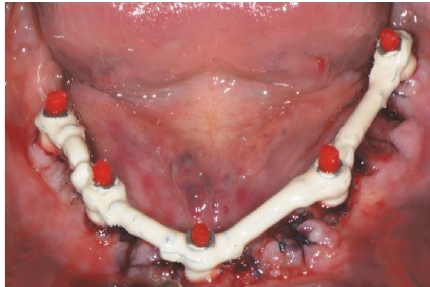
Figure 8: After the intraoral welding, the self-locating bar was removed from the mouth and finished, blasted, and then covered with a white opaque composite resin. The bar was subsequently repositioned onto the MUA